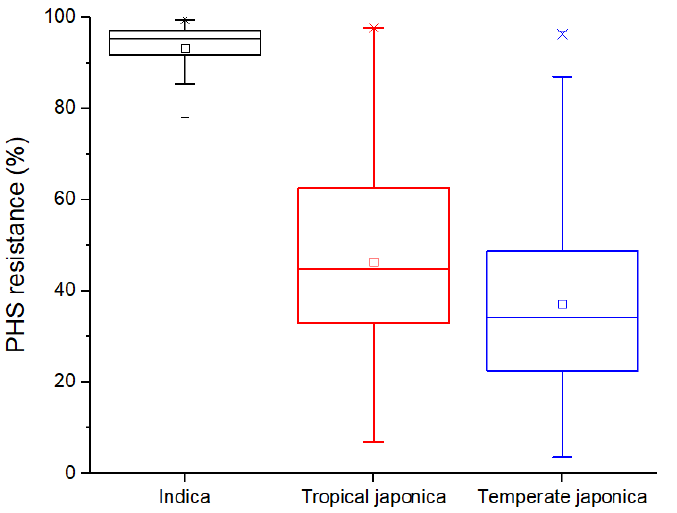
Figure 4. Pre-harvest sprouting resistance variation of indica ( black ), tropical japonica ( red ), and temperate japonica ( blue ) rice sub-groups harvested at 30 days after flowering.